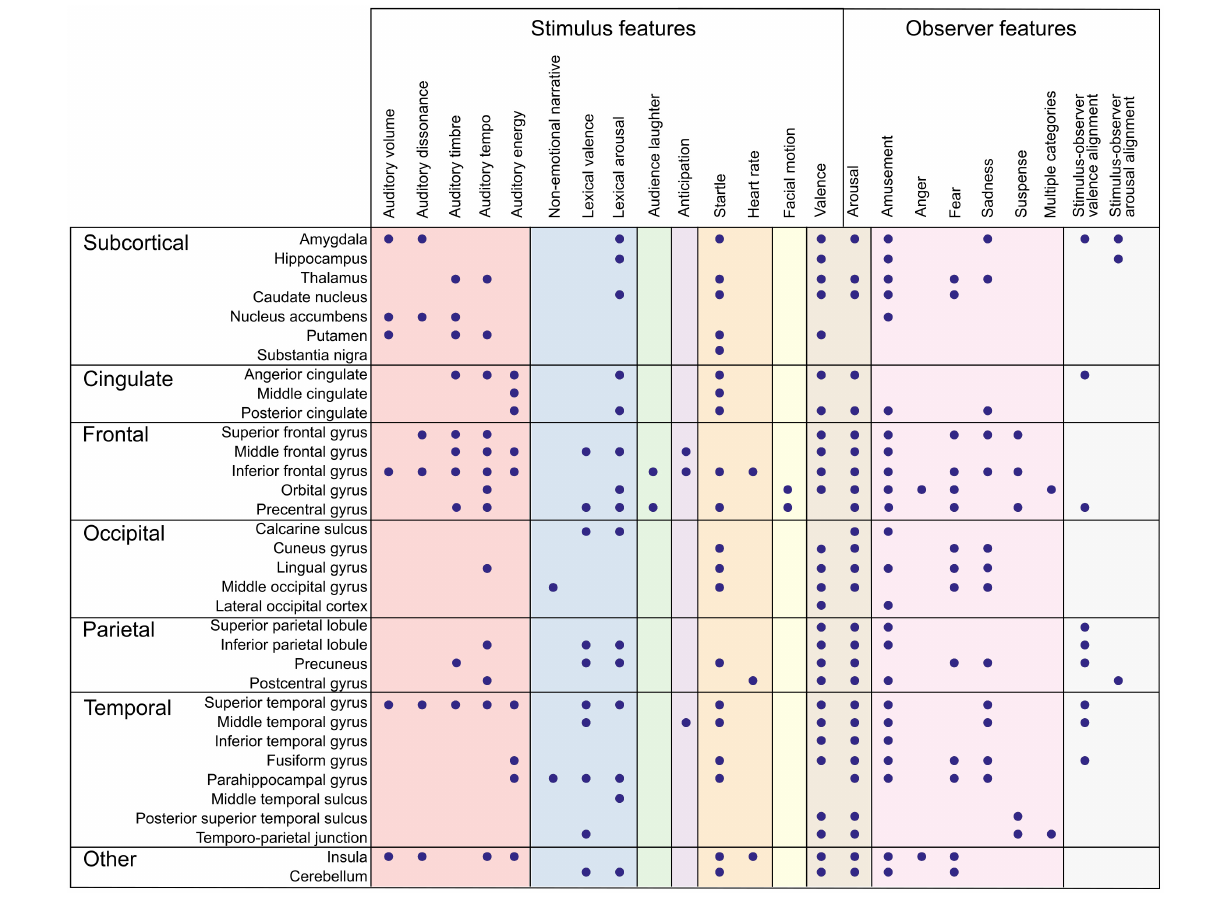
FIGURE 2 | Summary of brain regions correlating with emotion features. Dots denote an observed association between the brain region (rows) and the emotion feature (columns). Color panels denote feature categories (from left to right): low-level auditory features (red), object-level features (blue), portrayed emotions (green), emotion elicitation (violet), interoception (orange), behavior (yellow), affective dimensions (brown), emotion categories (pink), and emotional alignment (gray). Directionality of association and more detailed anatomical locations are listed in Supplementary Table 1